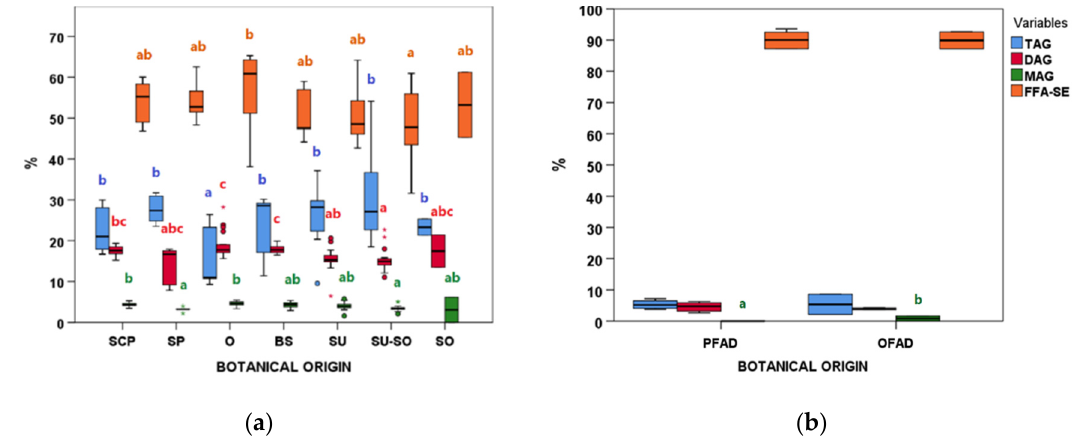
Figure 5. Triacylglycerols (TAG), diacylglycerols (DAG), monoacylglycerols (MAG), and free fatty acids (FFA-SE) boxplots according to botanical groups for ( a ) acid oils from chemical refining ( n = 79) and ( b ) fatty acid distillates from physical refining ( n = 8, lauric FAD group was excluded) (see Table 1 for botanical group abbreviations). Within each type of refining and variable, botanical groups bearing different letters (a–c) are significantly different according to Kruskal–Wallis test and post-hoc comparisons ( p ≤ 0.05).